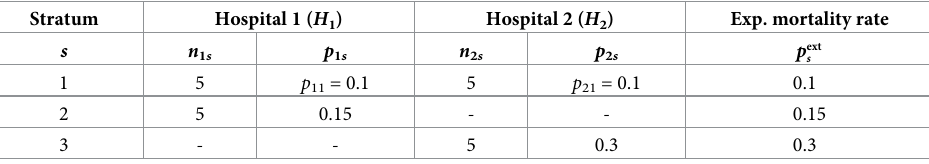
Table 3. Example of variations in actual mortality rates under external standardization: Initial parameter values.